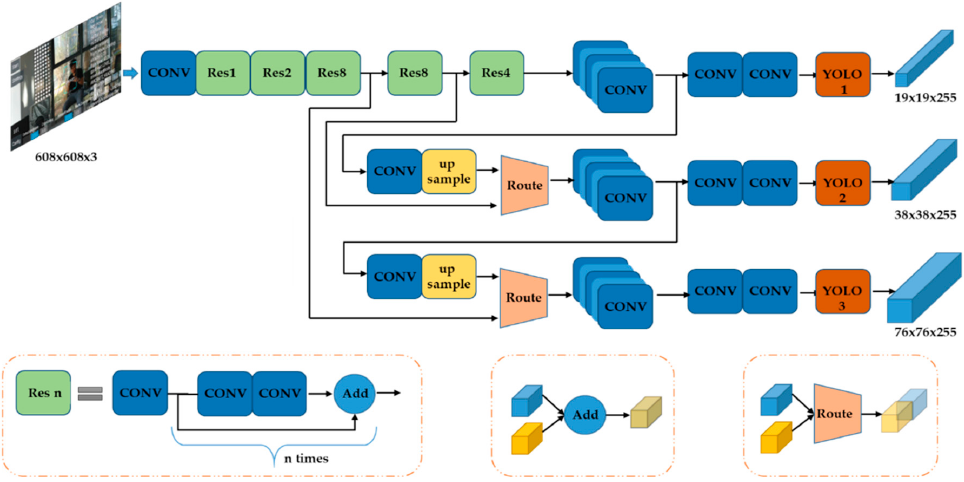
Figure 5. Structure of YOLOv3 used as recognition part of the method. Algorithm 1 Color Blob Detection.